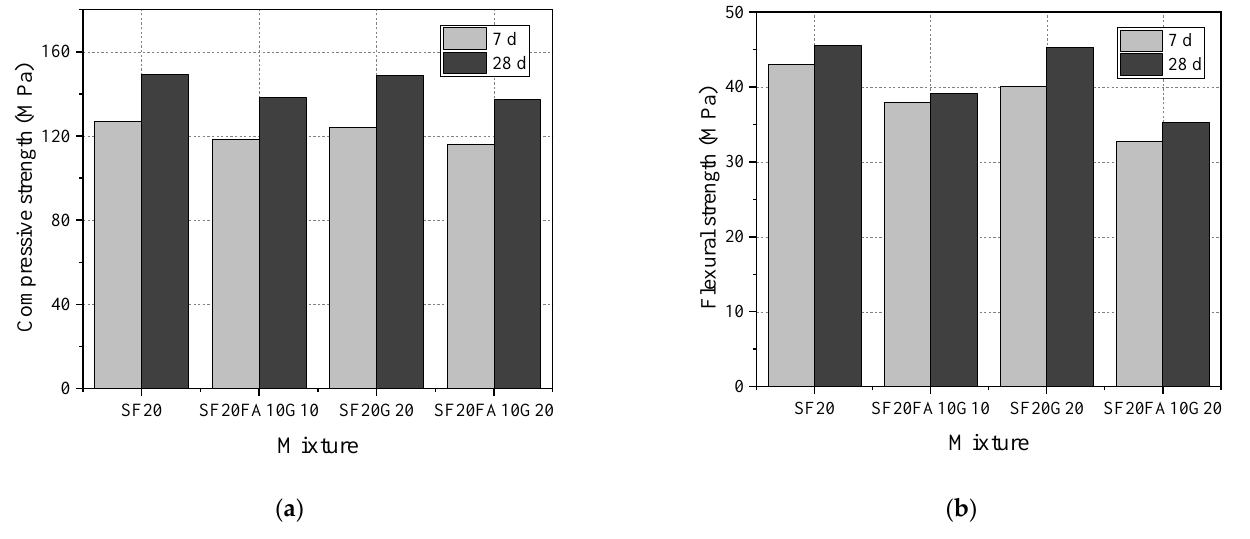
Figure 1. Compressive and flexural strengths of EUHPC under standard curing: ( a ) compressive strength; ( b ) flexural strength.